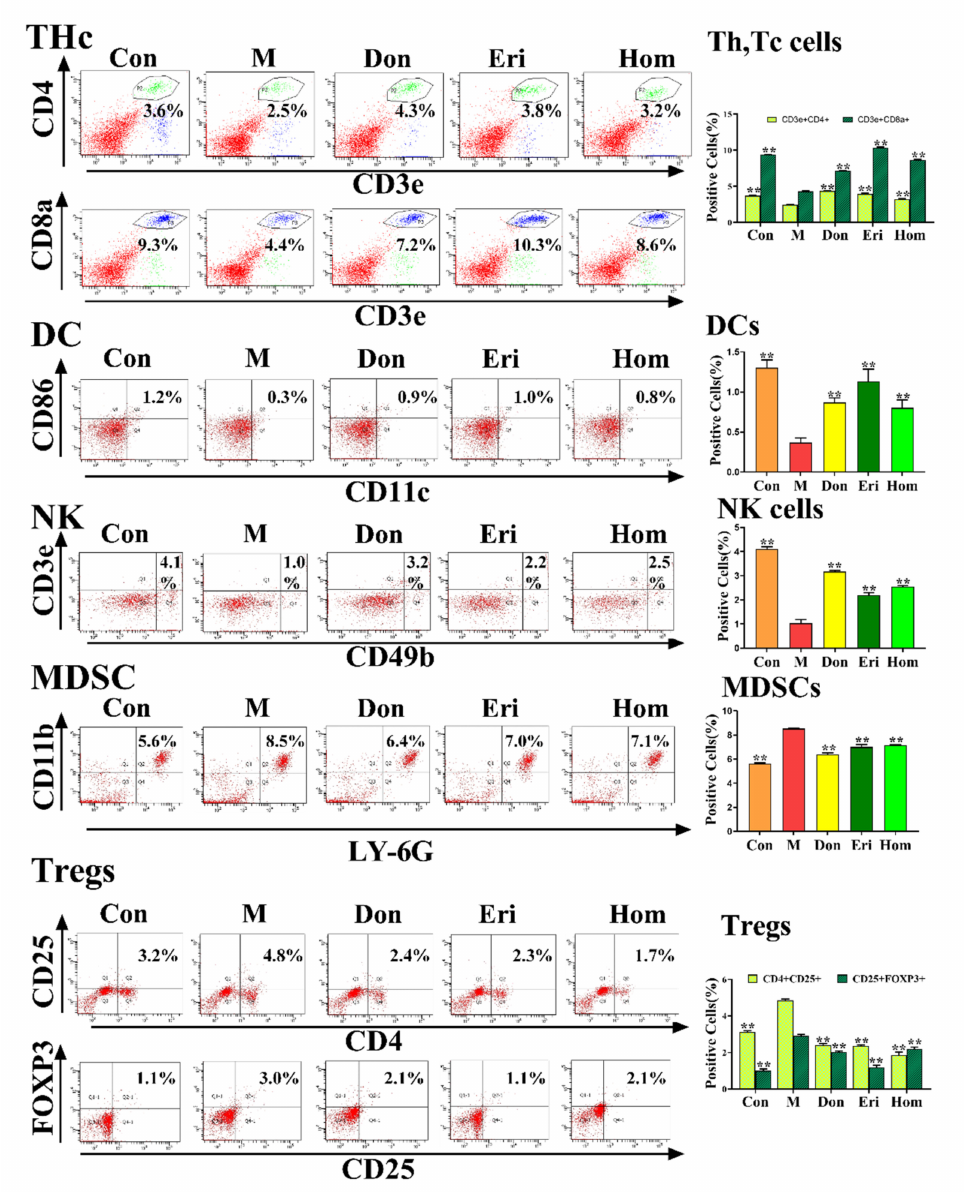
Figure 5. Eri and Hom regulate the level of immune cells in mice injected with A β 25-35. Flow cytometry detected Th cells (CD3e+, CD4+), Tc cells (CD3e+, CD8a+), NK cells (CD49b+, CD3e+), DCs cells (CD11c+, CD86+), Tregs cells (CD4+, CD25+, FOXP3+), and MDSC cells (LY6G+, CD11b+) in the peripheral blood of mice. The immune cell quantification results are shown on the right side of the figure above; the data were expressed as the mean ± SD. n = 3, ** p < 0.01 compared with the M group. Con means the control, M means the model, Don means the donepezil, Eri means the eriodictyol, Hom means the